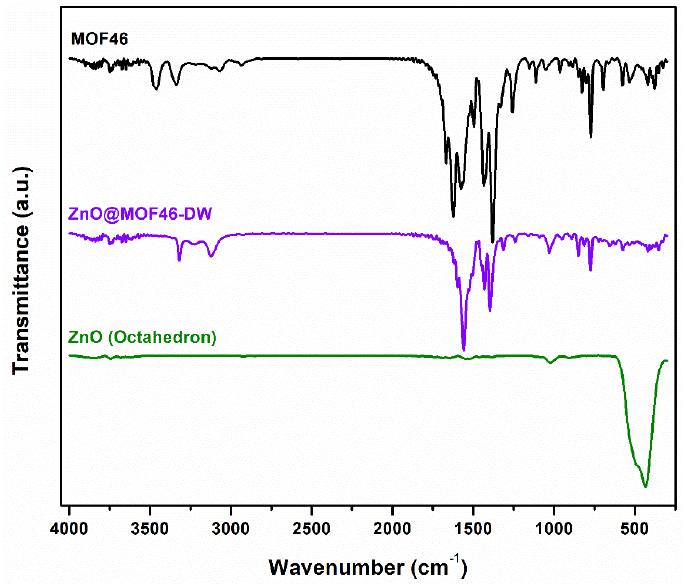
Figure 14. FTIR spectra of synthesized ZnO@MOF-46(Zn)-DW relative to the FT-IR spectrum of pure MOF-46(Zn) and ZnO.